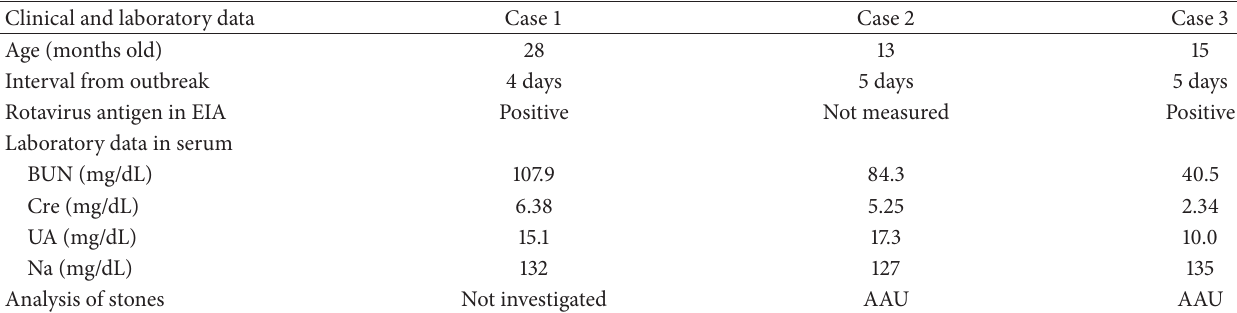
Table 1: Summary of the clinical and laboratory data for the three cases.